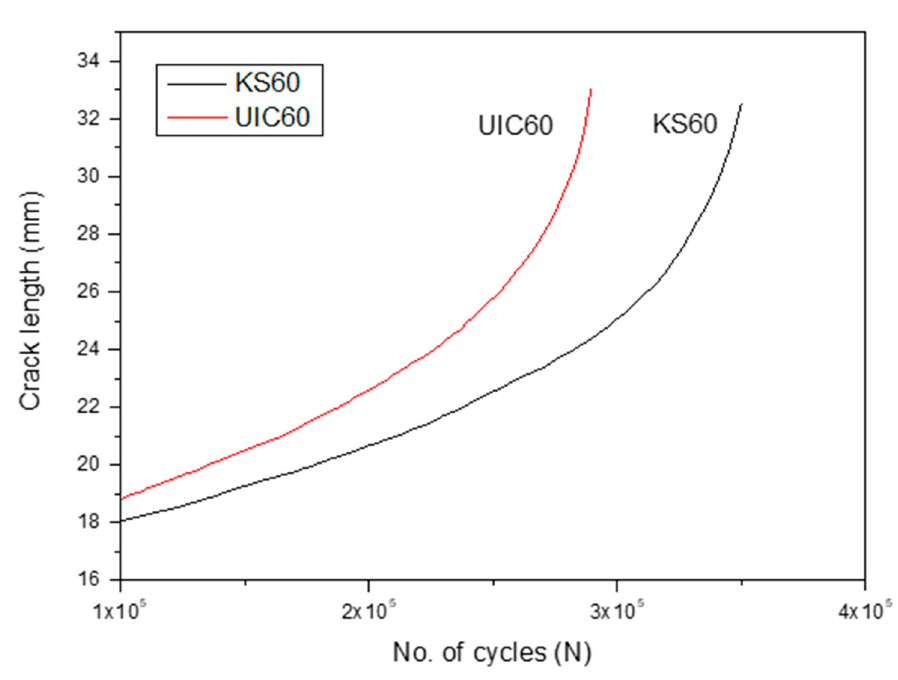
Figure 9. Comparison of fatigue crack growth rate.